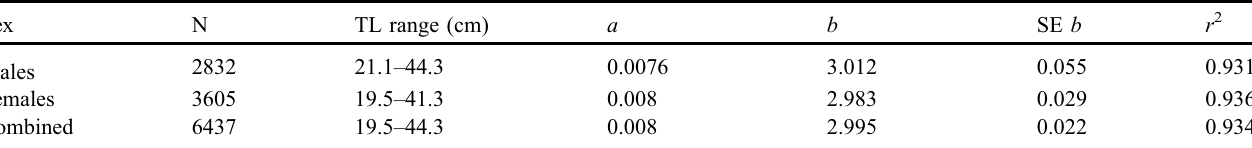
Table 2. Parameters of the morphometric relationships GW = a TL b established between total length (TL) and gutted weight (GW) for